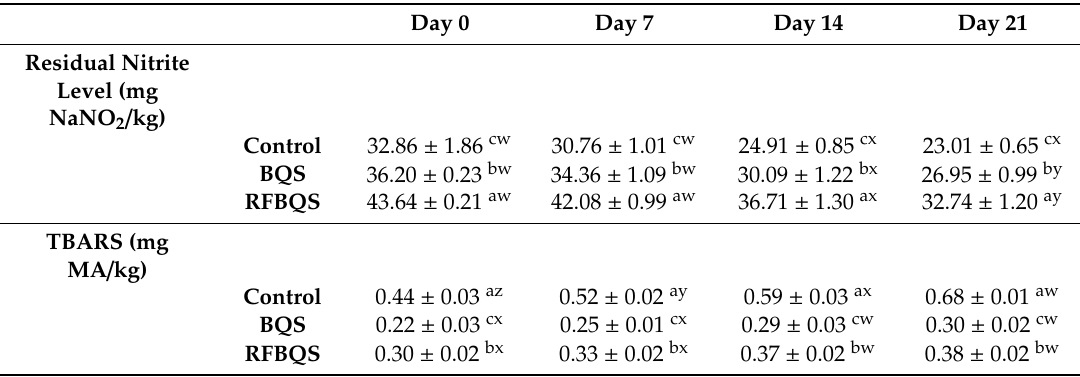
Table 3. Residual nitrite level and Thiobarbituric acid reactive substances TBARS values during storage of Bologna-type sausages containing black quinoa